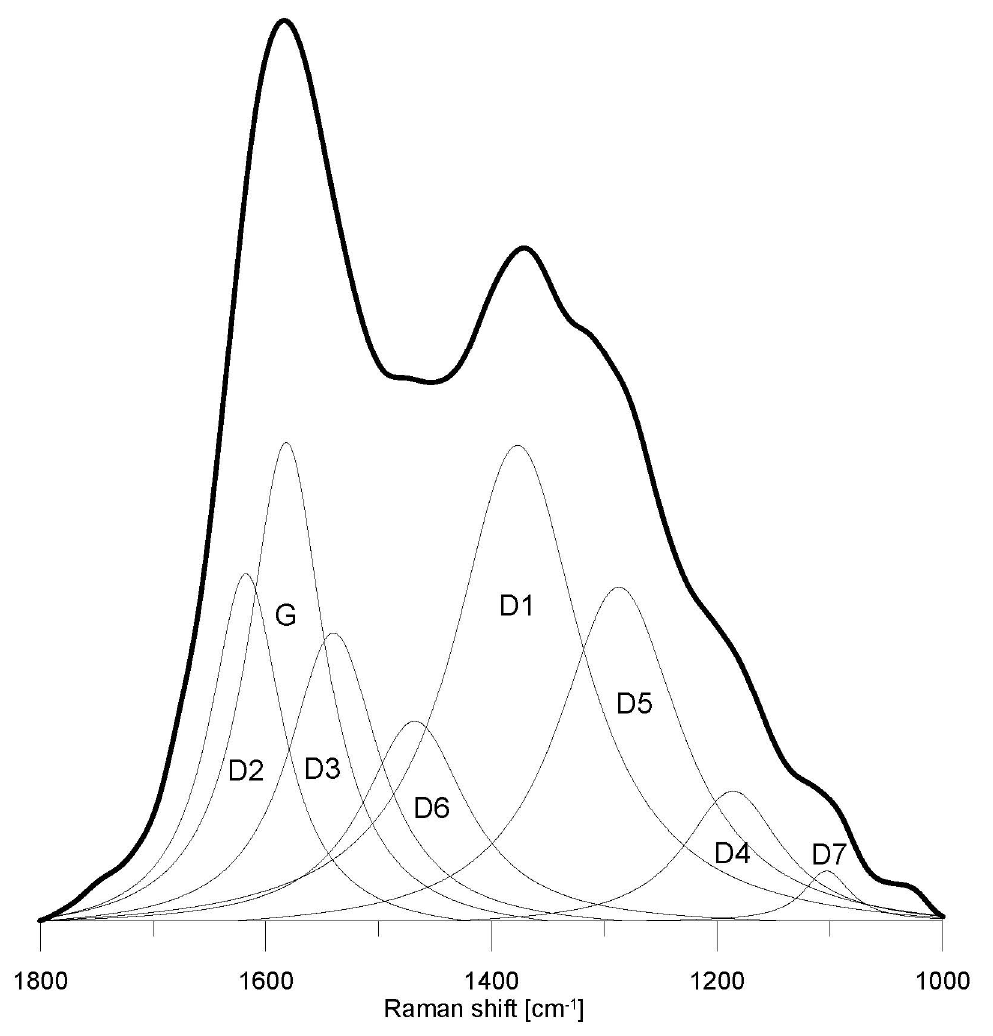
Figure 3. Curve-fitting of a representative attrinite spectrum.